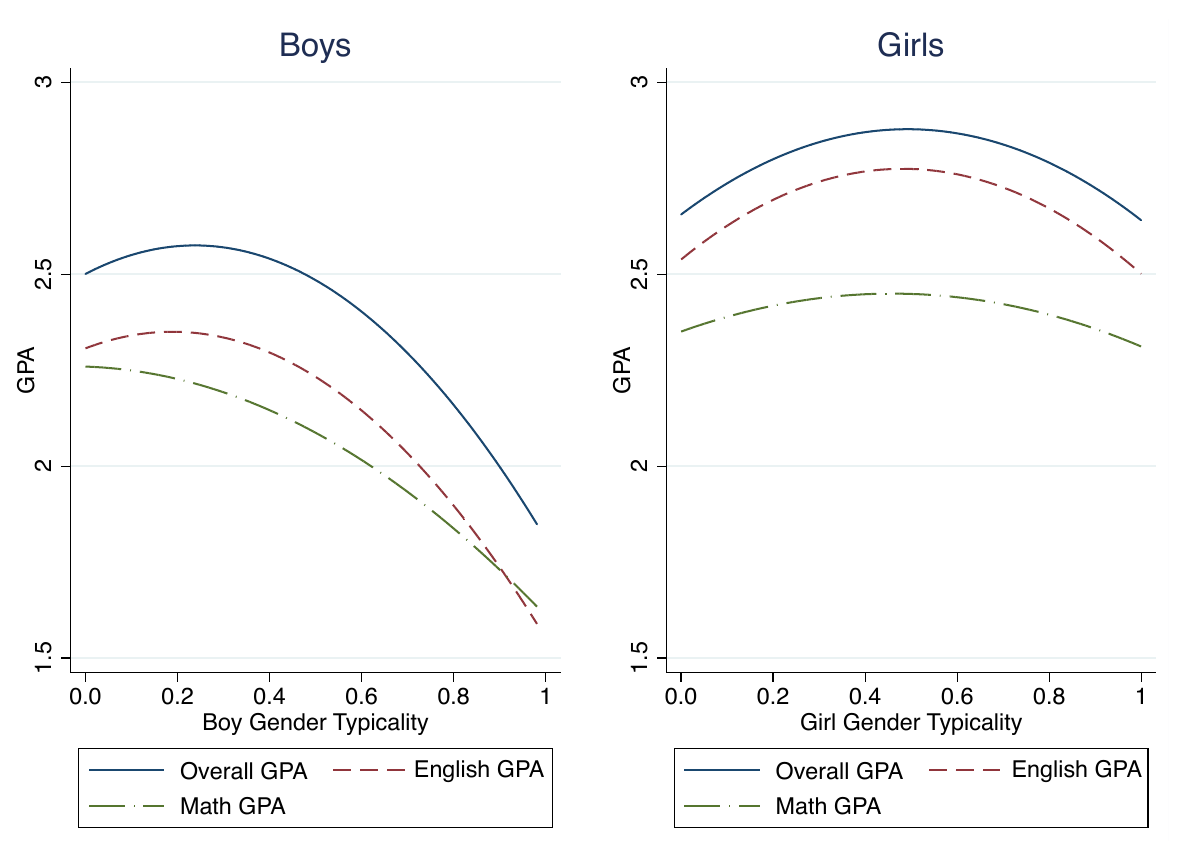
Figure 3: Boys’ and girls’ predicted transcript grade point averages based on gender typicality. earn the highest overall GPA relative to girls at the tails of the distribution who display either very gender-typical or very gender-atypical